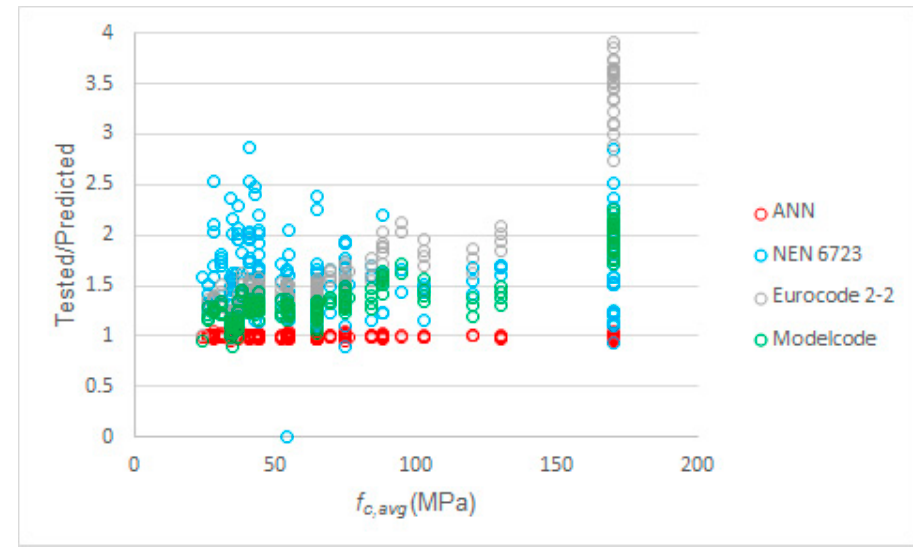
Figure 8. Tested to predicted values for all considered methods as a function of the average concrete compressive strength.